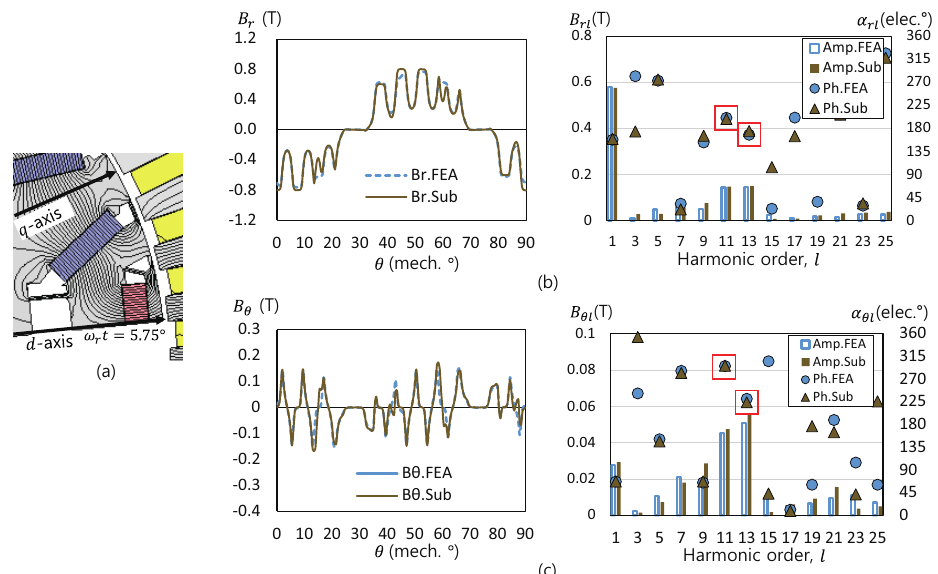
Figure 3. Comparisons of instantaneous air-gap fields when the cogging torque is maximum: ( a ) flux lines, ( b ) radial fields, and ( c ) circumferential fields. The second part is shown in Figure 4, where the PMs are unmagnetized. Instead, current i q = 185 A is injected to the stator coil with zero current angle. Note that the current angle ( β ) is defined as the angle of the current vector with respect to the q -axis. When β = 0, the current vector consists of only the q -axis component, and the d -axis current is equal to zero. Similarly to the previous results, the most dominant harmonic numbers are found at 11 and 13 orders. The subdomain and FEA results generally agree well, but there are some differences in the magnitude of the harmonics. However, the phases of the dominant harmonic components appear to be approximately the same.